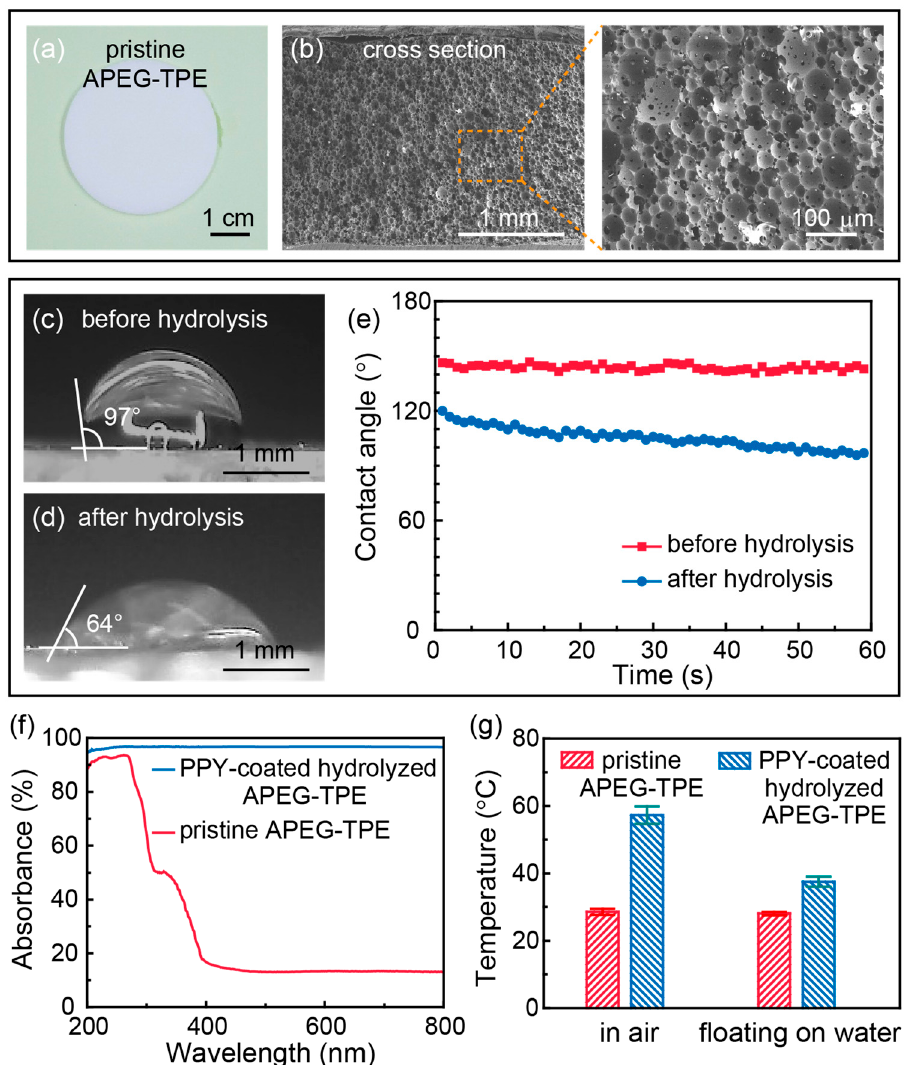
Figure 3. Optimizations of APEG-TPEs. ( a ) Opitical and ( b ) SEM images of pristine APEG-TPEs, showing inter-connected pores in the cross section. If not specified, the oil-to-water ratio of APEGs is 1:9 and the oil phase consists of 40% styrene, 50% t -butyl acrylate and 10% divinyl benzene. ( c ) and ( d ) Static and ( e ) dynamic contact angles of water droplets on plain samples before and after hydrolysis of t -BA. ( f ) Light absorption of pristine APEG-TPEs and PPy-coated hydrolyzed APEG- TPEs. ( g ) Equilibrium surface temperatures of pristine APEG-TPEs and PPy-coated hydrolyzed APEG-TPEs in air or floating on water after 1 hour’s irradiation of simulated sunlight.